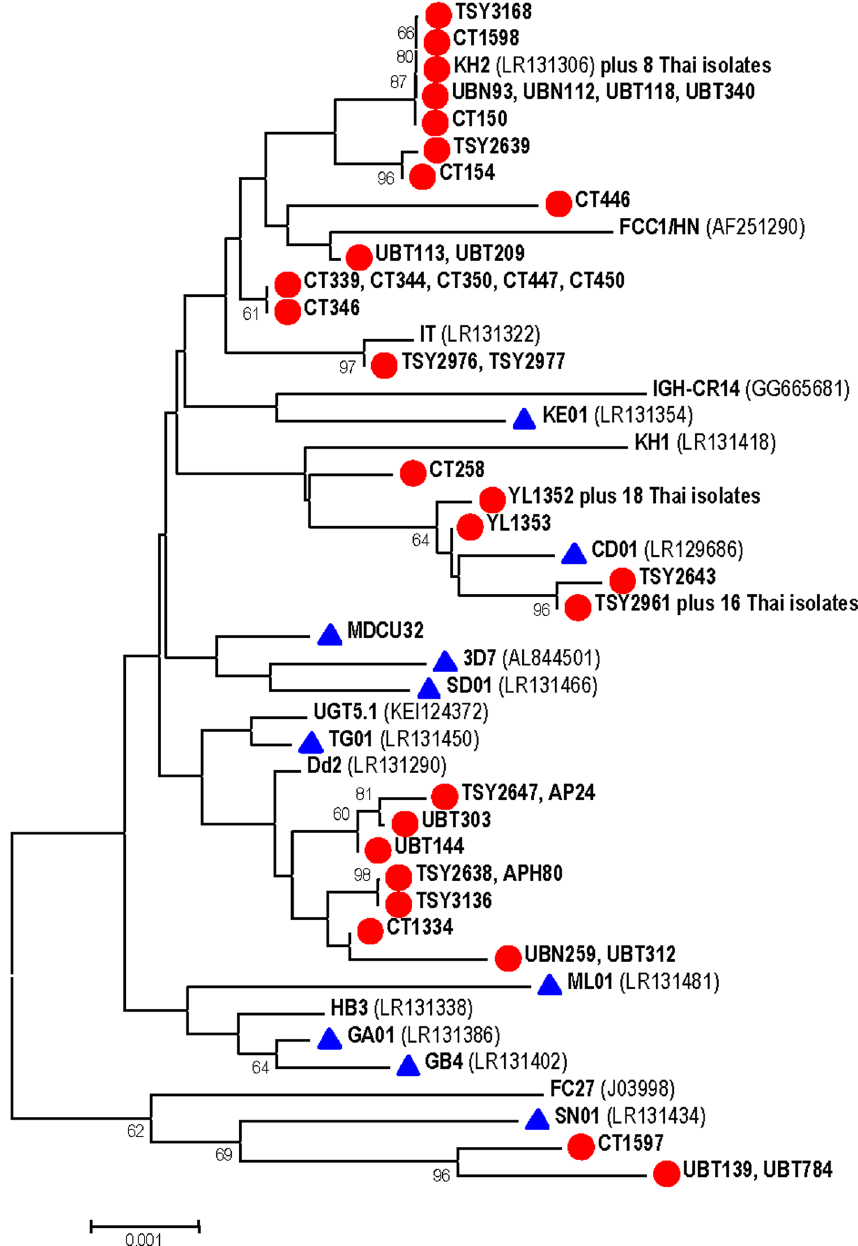
Figure 2. Neighbor-joining tree inferred from the complete PfGARP gene sequences from Thai and worldwide isolates. Thai isolates with initials TSY and AP are from Tak, UB from Ubon Ratchathani, YL from Yala and CT from Chanthaburi Provinces. The numbers following these initials are used to label individual isolates. Bootstrap values greater than 60% are shown along the branches. Thai and African isolates are marked with circles and triangles, respectively. Scale denotes nucleotide substitutions per site.